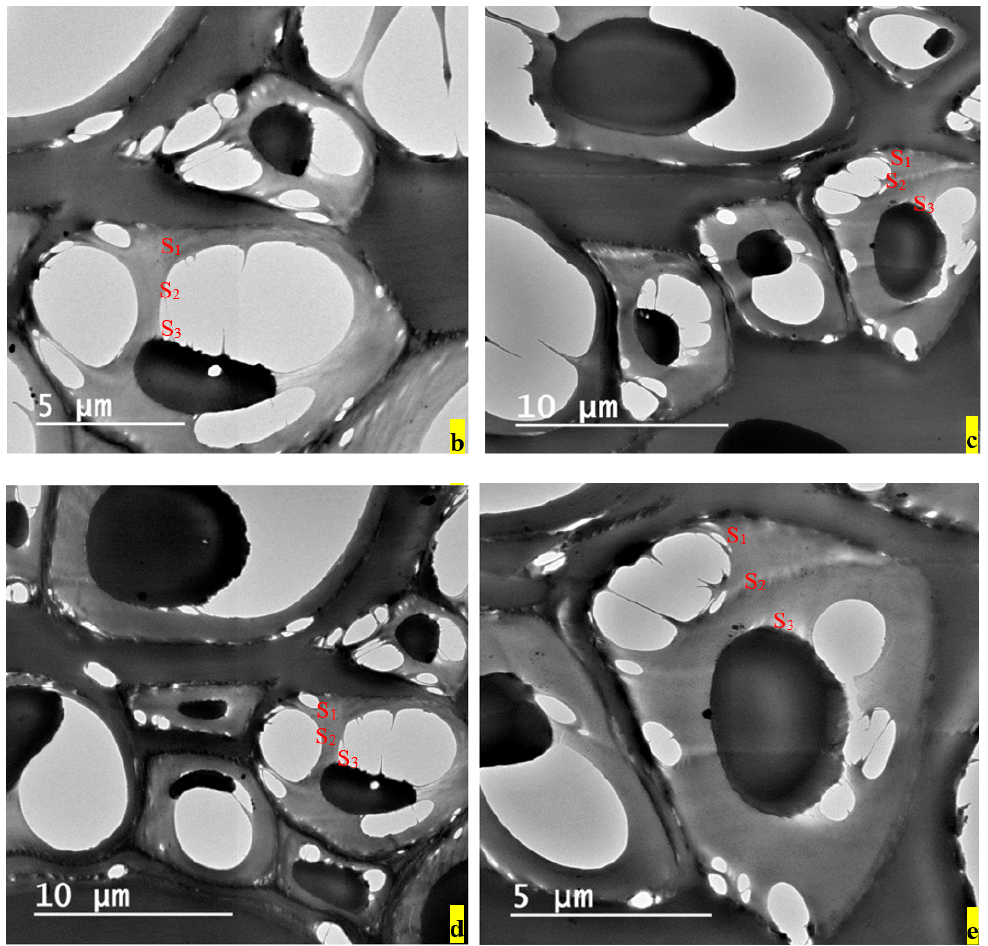
Figure 2. Transmission electron microscope (TEM) photos of control treatment ( a ) and wood samples infected with A. niger ( b – e ) , showing the effect of the fungus on the wood cells, which appears in the presence of soft-rot cavities, especially within the S 1 and S 3 layers. ML—middle lamella; S 1 , S 2 , S 3 — secondary cell wall layers of wood.